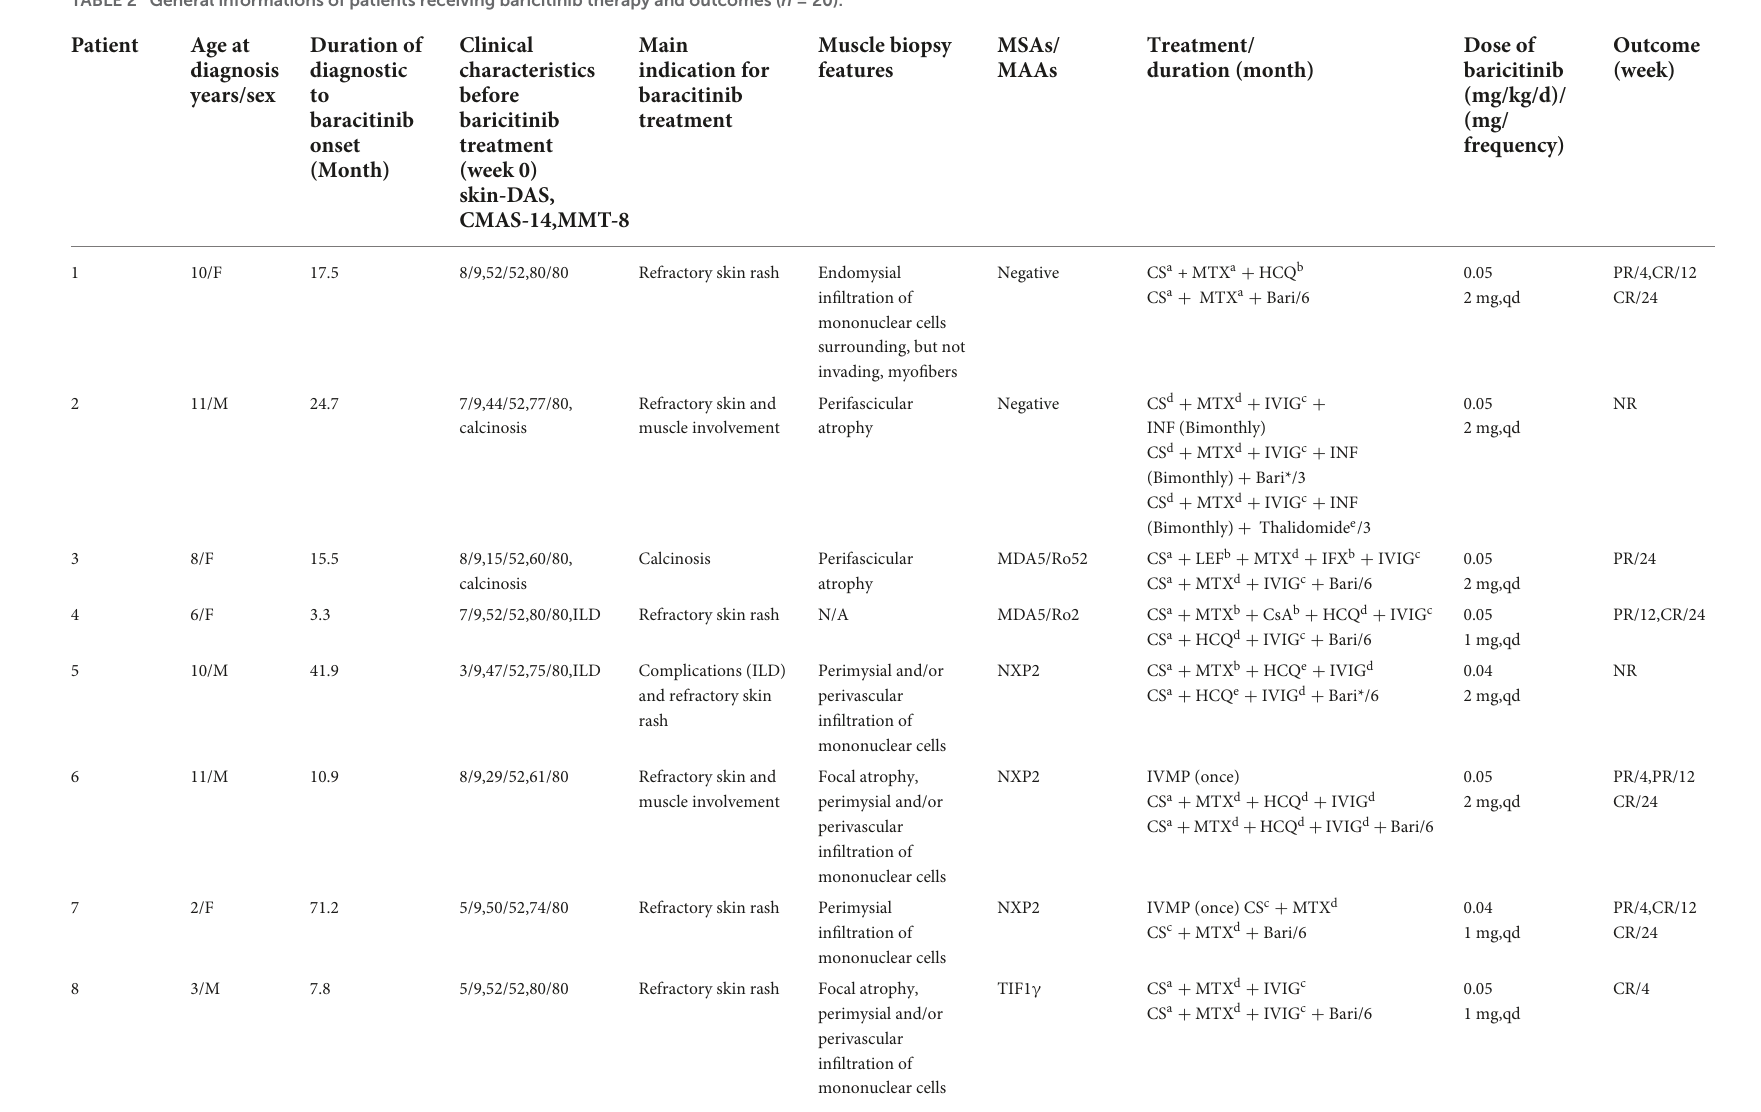
TABLE 2 General informations of patients receiving baricitinib therapy and outcomes ( n =